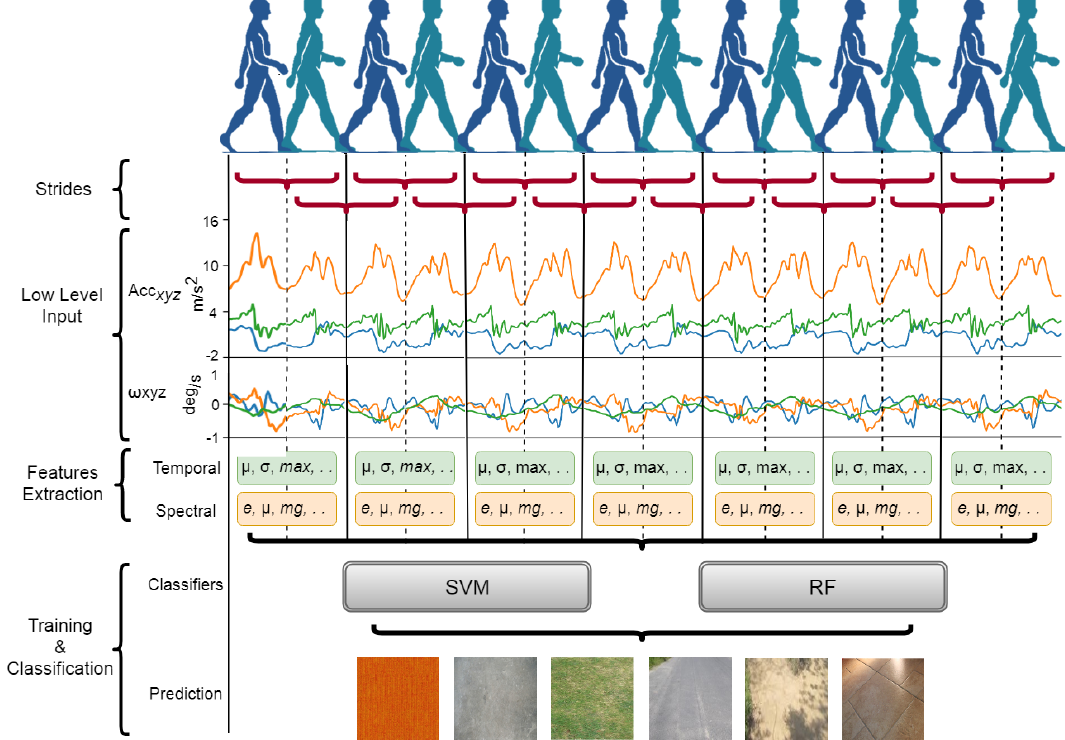
Figure 3. General work flow of terrain classification system. The input signals were segmented into strides and tempo-spectral features were extracted. Two different types of classifiers, i.e., Support Vector Machine (SVM) and Random Forest (RF), were trained to predict